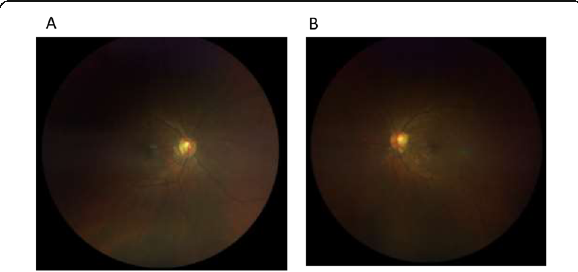
Fig. 4 a Fundus photo of the right eye after treatment with high dose of corticosteroids with resolution of areas of subretinal fluid and also complete resolution of hemorrhages. b Fundus photo of the left eye after treatment with high dose of corticosteroids with resolution of areas of subretinal fluid and also complete resolution of